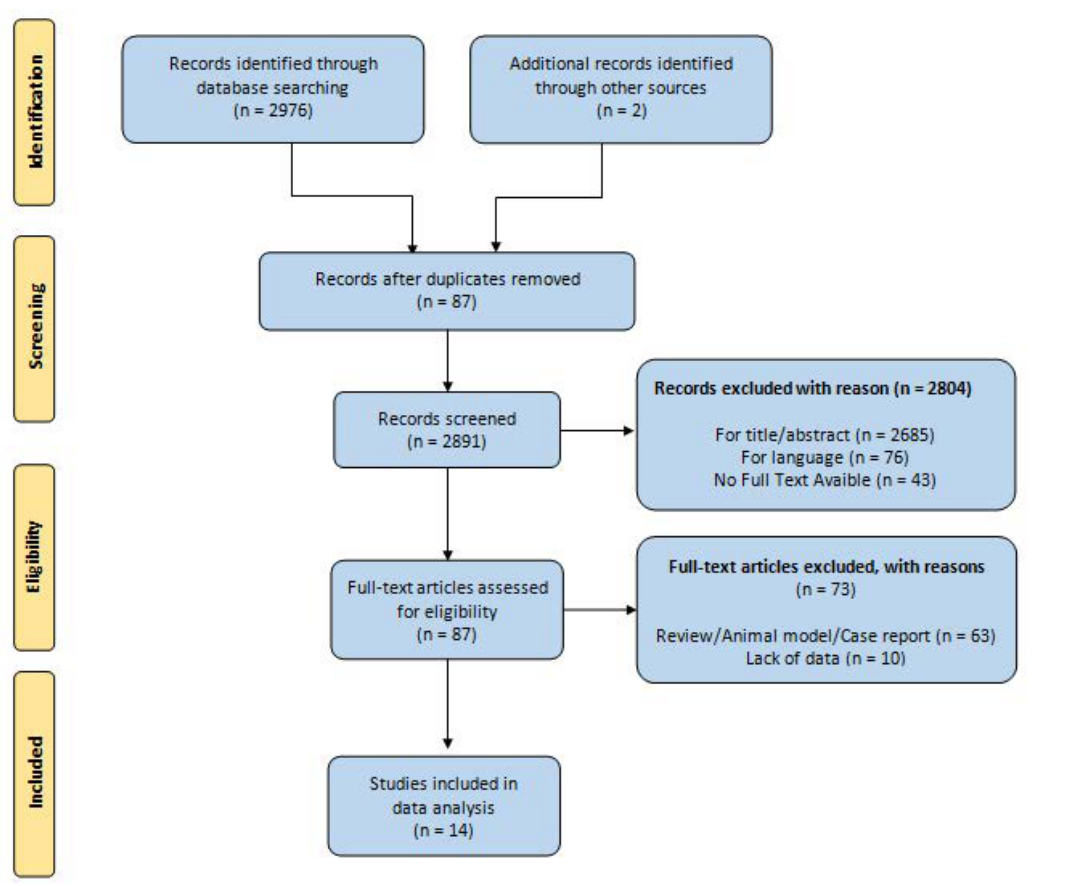
Figure 1. PRISMA Figure 1. PRISMA flowchart.